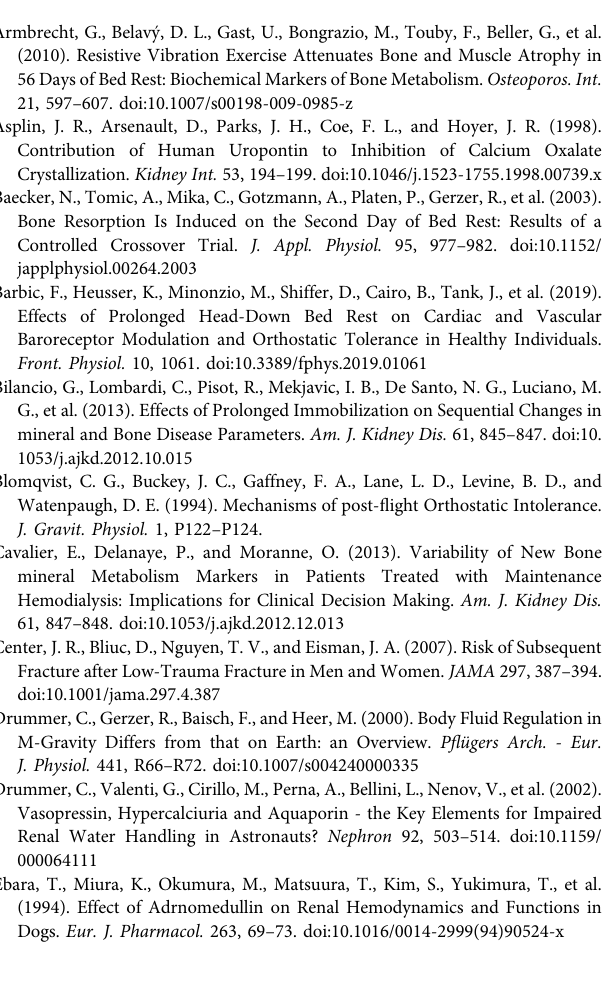
Figueres, L., Hourmant, M., and Lemoine, S. (2020). Understanding and Managing Hypercalciuria in Adults with Nephrolithiasis: Keys for Nephrologists.